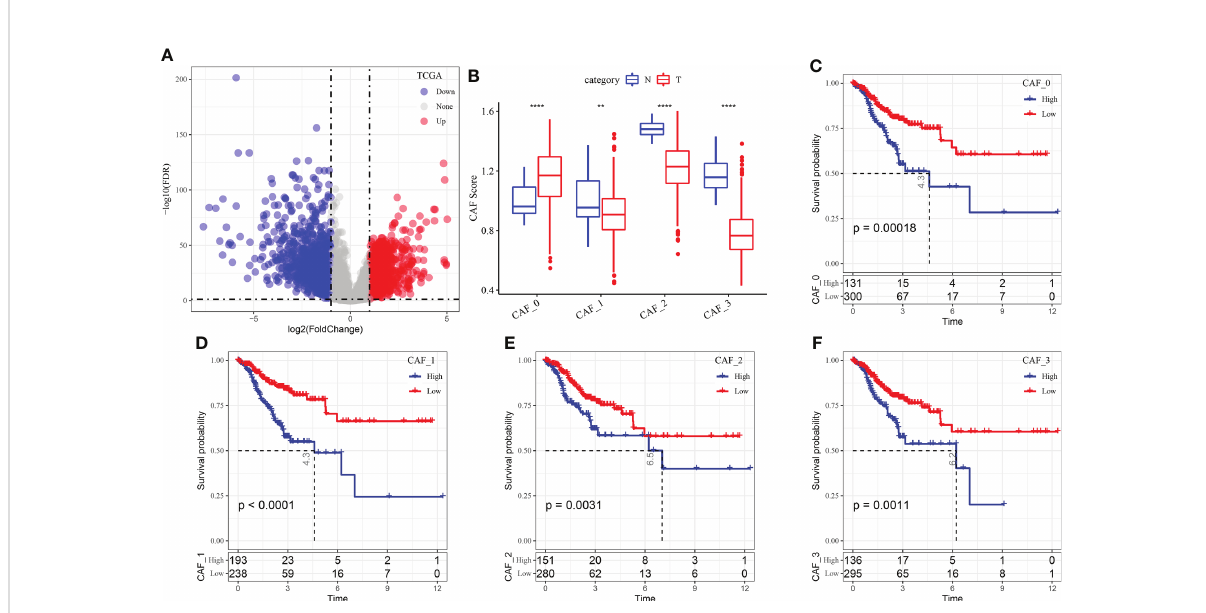
FIGURE 3 (A) Volcano map of differential gene expression between cancer and adjacent tissues in TCGA dataset; (B) The scores of the four fi broblast subgroups were compared between cancer and adjacent tissues (Wilcoxon test); (C) KM curve of the high- and low-score groups in the CAF_0 subgroup; (D) KM curve of the high- and low-score groups in the CAF_1 subgroup; (E) KM curve of the high- and low-score groups in the CAF_2 subgroup; (F) KM curve of the high- and low-score groups in the CAF_3 subgroup. **P < 0.01, ****P <